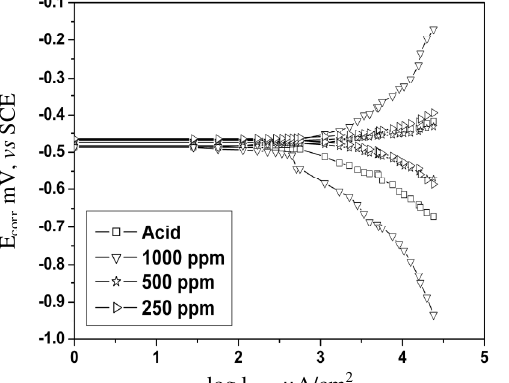
Figure 3. Galvanostatic polarization curve for different inhibitor concentrations in 1 N H SO at 303 2 4